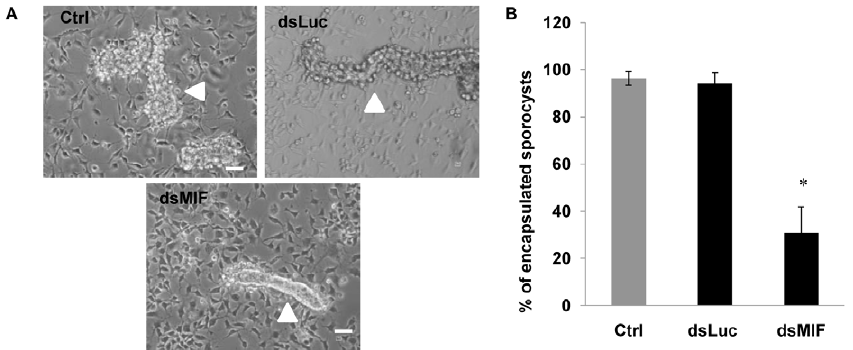
arrow. Note that, in the dsMIF culture, the sporocyst tegument remained easily visible and free of cells whereas in the control cultures, sporocysts became uniformly covered with Bge cells. (B) Quantification of sporocysts encapsulated by dsRNA-treated or untreated Bge cells. Sporocysts were deemed not to be encapsulated if Bge cells were found adhering to less than 10% of their surface. Scale bar represents 10 m m. The results are expressed as the percentage of sporocysts that were encapsulated and are the mean 6 SD of three independent experiments.